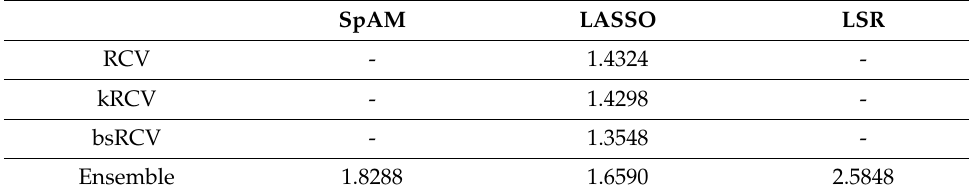
Table 2. Error variance estimation in maize dataset.